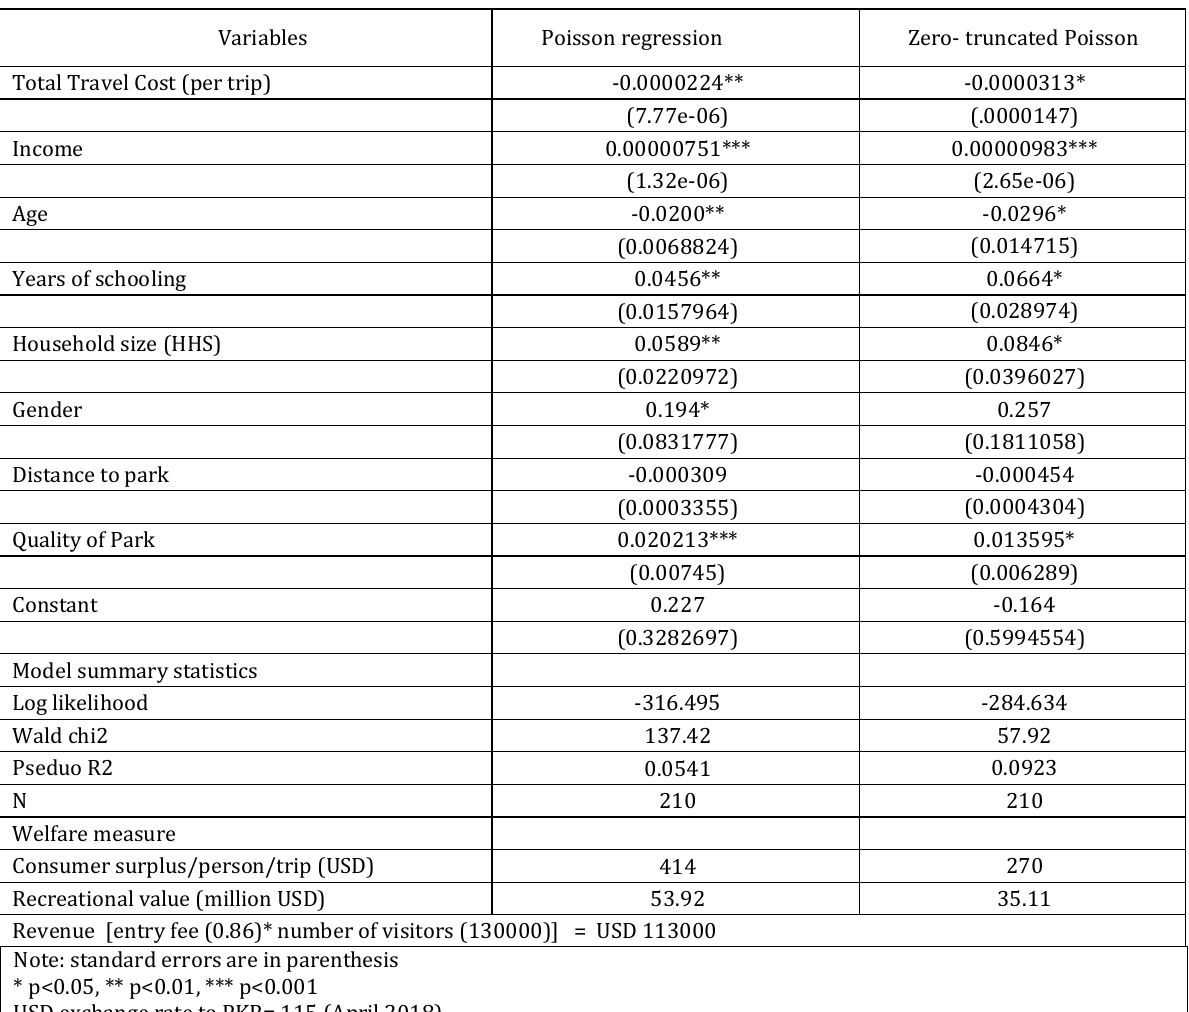
Table 3. Results of econometric